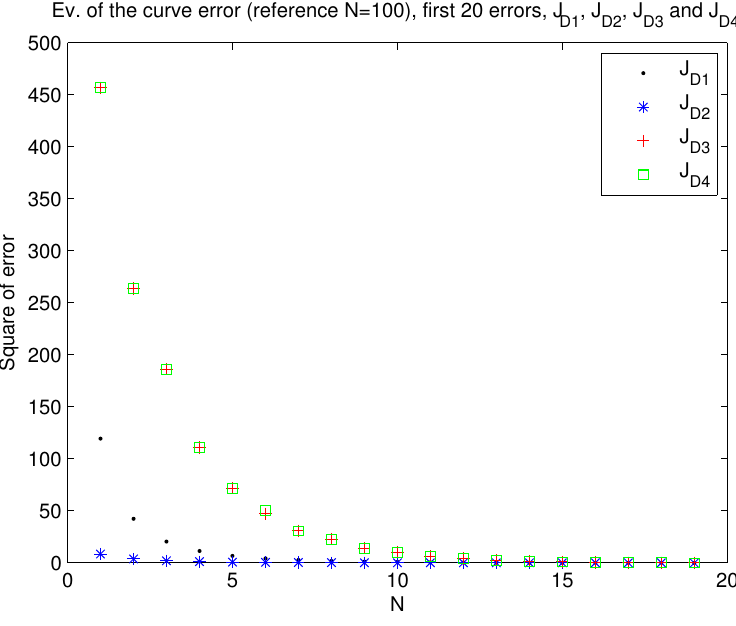
Figure 10. Influence of discretization factor